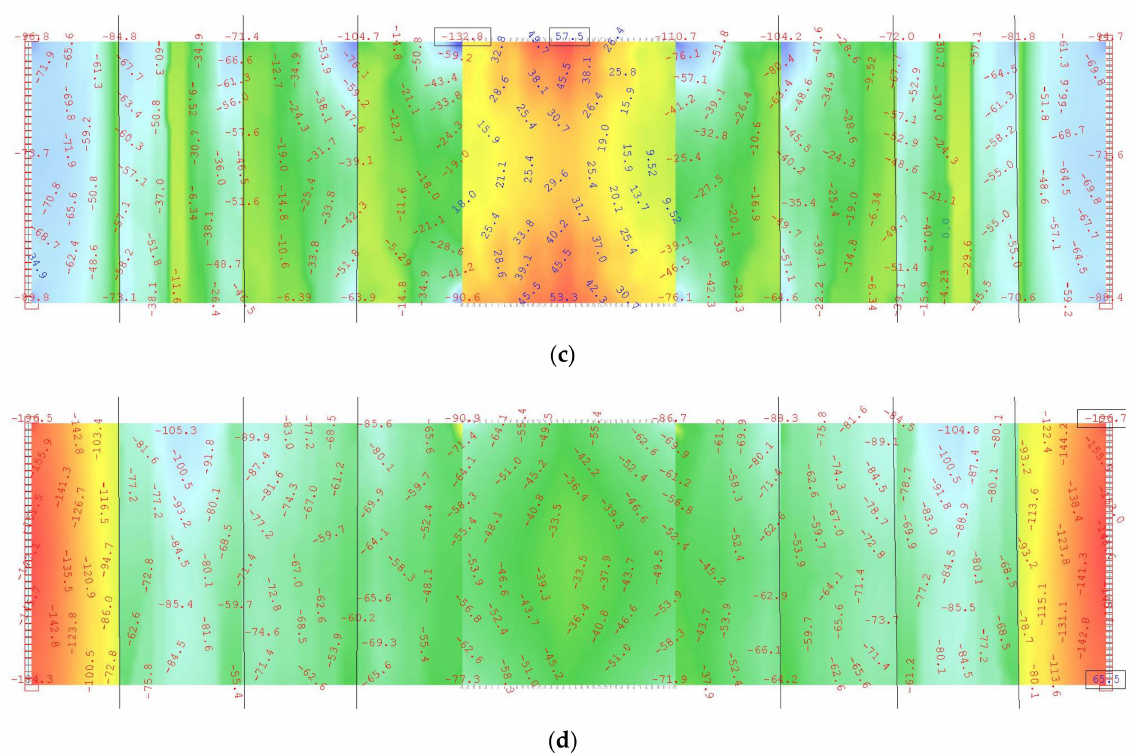
Figure A4. Envelope maps of characteristic values of forces N xx (kN) in the concrete arch: ( a ) Max Nxx (kN) under the moving load q of class C; ( b ) min Nxx (kN) under the moving load q of class C; ( c ) max Nxx (kN) under the moving load K of class C; ( d ) min Nxx (kN) under the moving load K of class C.